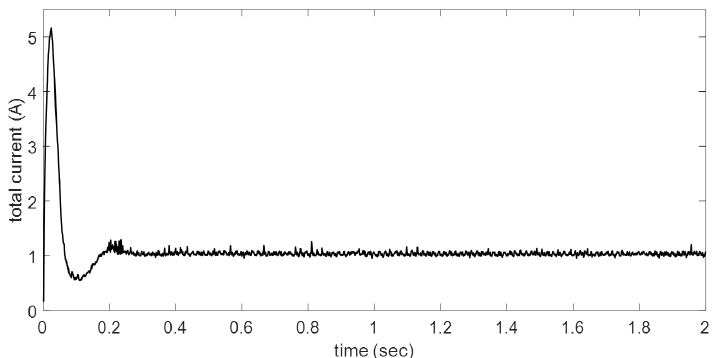
Figure 7. Total current performance, case a .